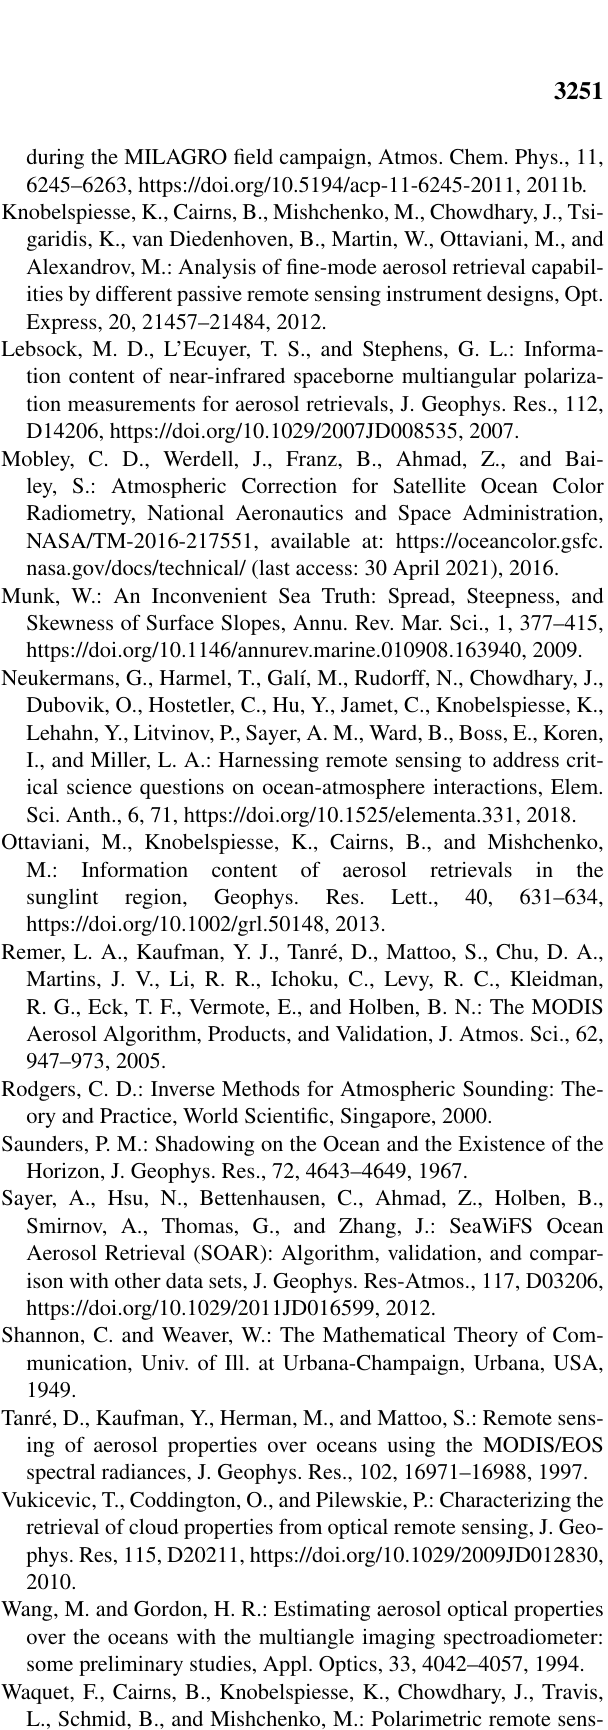
Knobelspiesse, K.: Individual figures similar to Figure 3,